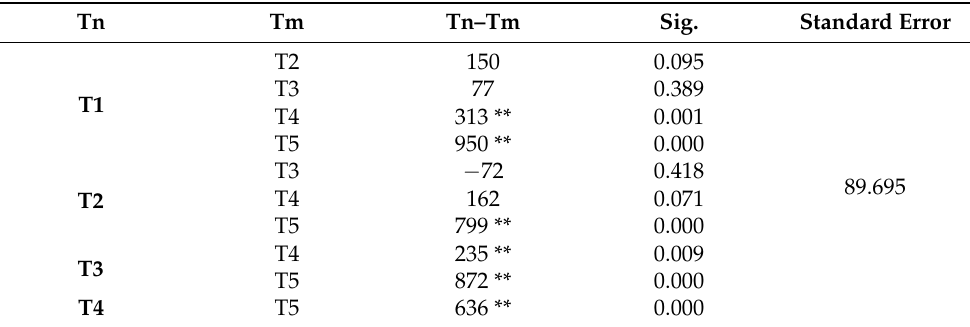
Table 8. Differences in mean yield (kg/ha) for defoliation